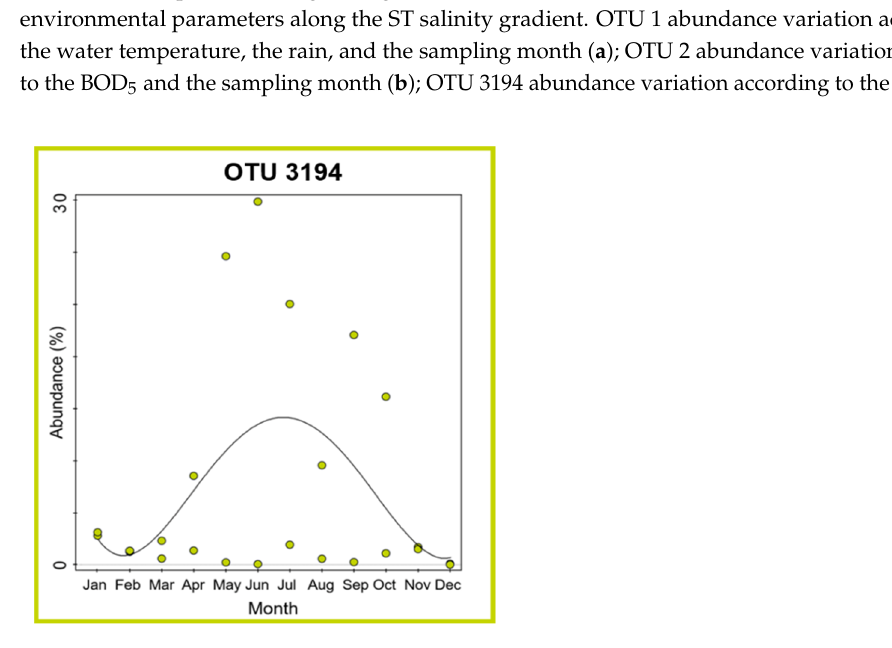
Figure 8. GLM plot showing the significant abundance variation of OTU 3194 in relation to the sam- pling month in BSB. sampling month in